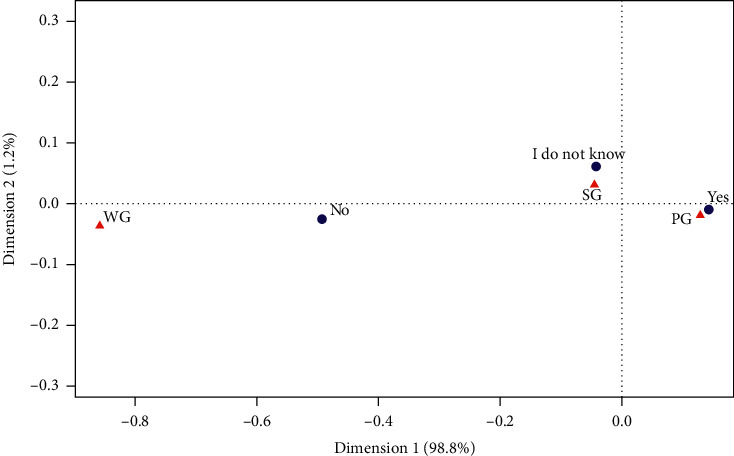
The analysis of correspondence regarding premenstrual syndrome and dysmenorrhea among the studied female respondents. PG, women with dysmenorrhea during every cycle, SG, women with dysmenorrhea occasionally, and WG, women without dysmenorrhea.